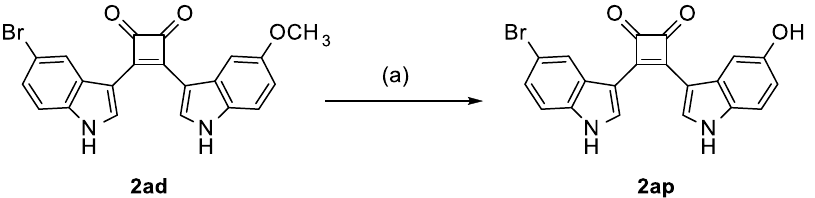
a n.d. = not determined. b Concentration [µM] for 50% inhibition of P. falciparum (NF54- luc strain) erythrocytic stages. c Inhibition of P. falciparum (NF54- luc strain) erythrocytic stages at 3 µM. d determined at 30 µM. e Blasticidin (BSD) was Table 1. Structures and antiplasmodial activity of bisindolylcyclobutenediones 2a – ar and bisindolylmaleimide 8 a . used as the positive